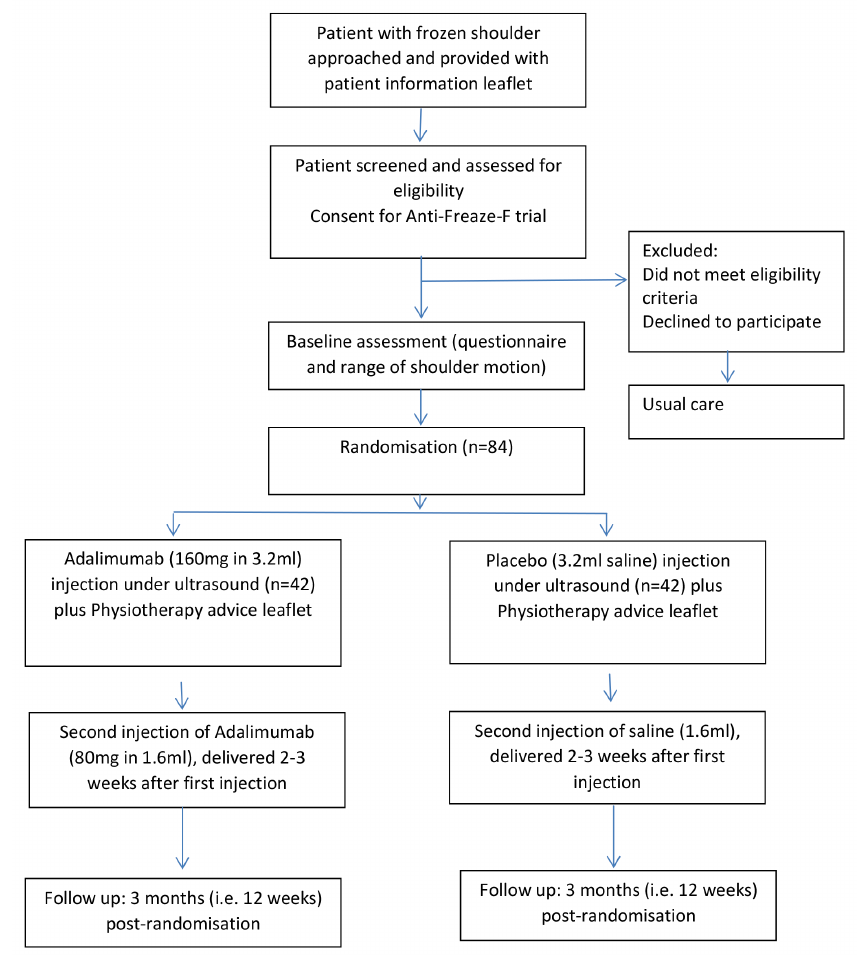
Figure 1. Study flow diagram for Anti-Freaze-F